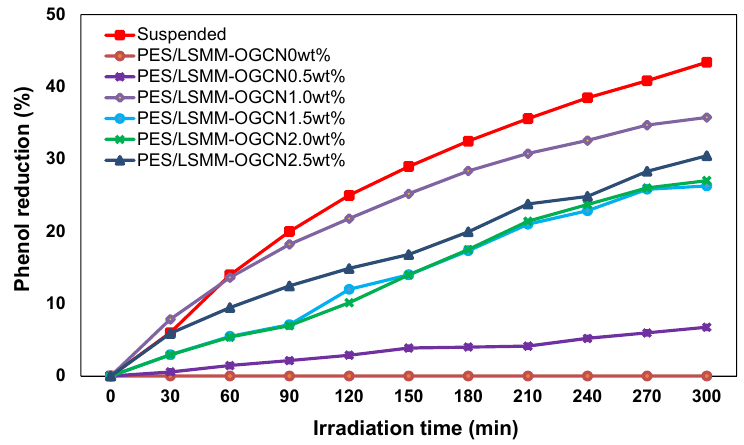
Figure 9. Phenol reduction via photocatalytic oxidation versus irradiation time for PES/LSMM ‐ OGCN membrane.